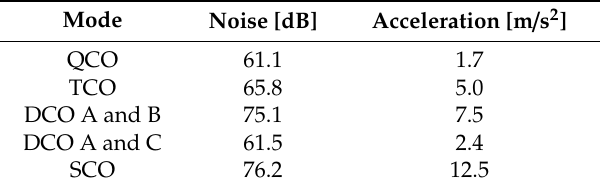
Figure 17. Speed vs. torque load ( a ), overall efficiency vs. torque load ( b )—variant II. Table 3. Selected results of the acceleration and the noise level.